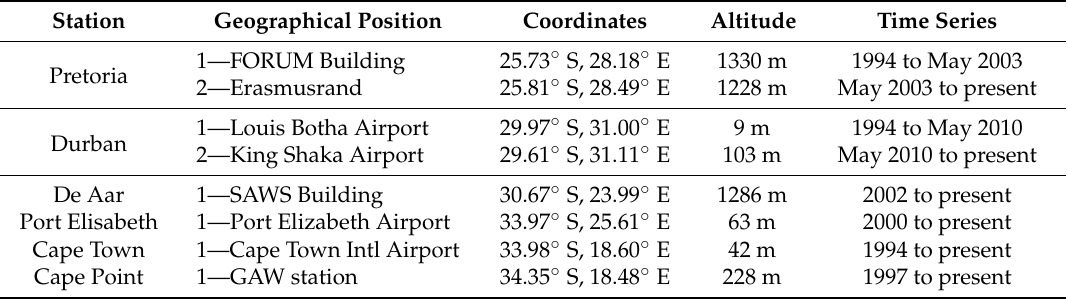
Figure 1. Geographical locations of the six South African Weather Service ground-based solar UVR measurement sites in South Africa. Table 1. Geographical information of the six South African Weather Service ground-based UV index measurement sites.